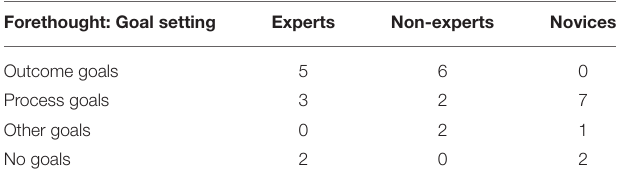
TABLE 3 | An overview of how different types of goals were set across the three skill levels. Forethought: Goal setting